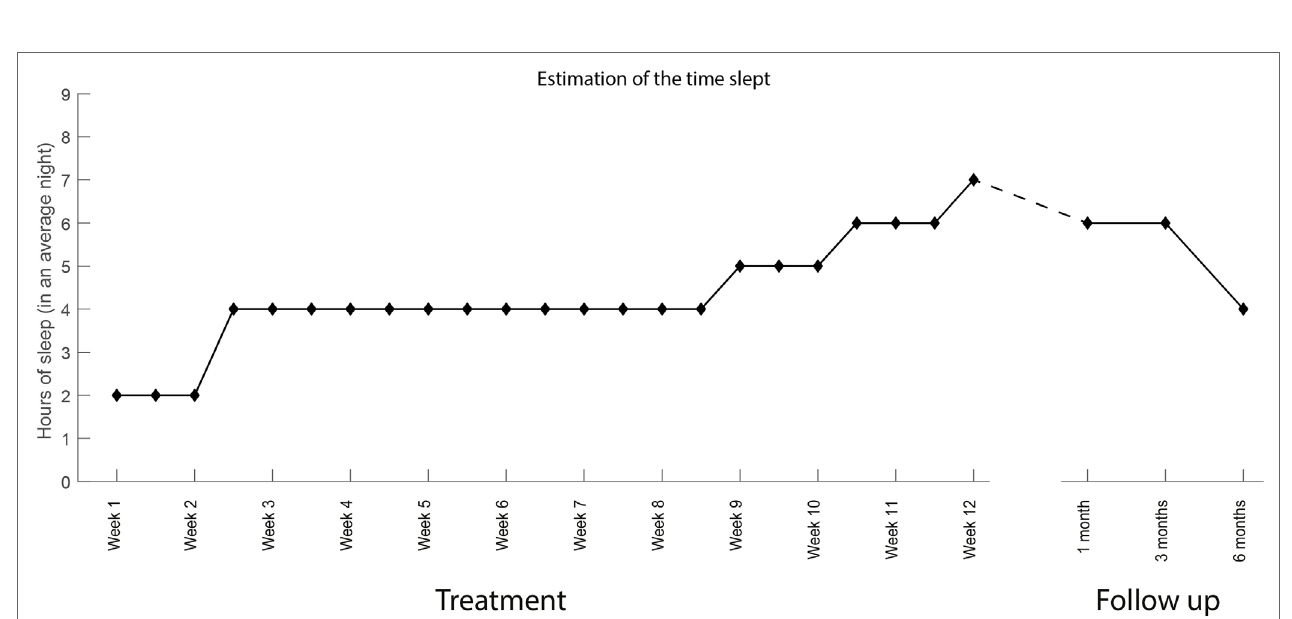
FigUre 9 | Weighted pain distribution (WPD) bar graph. Each bar represents a treatment session or a follow-up interview. The pain rating is from 0 to 5 where 5 (red) is the worst possible